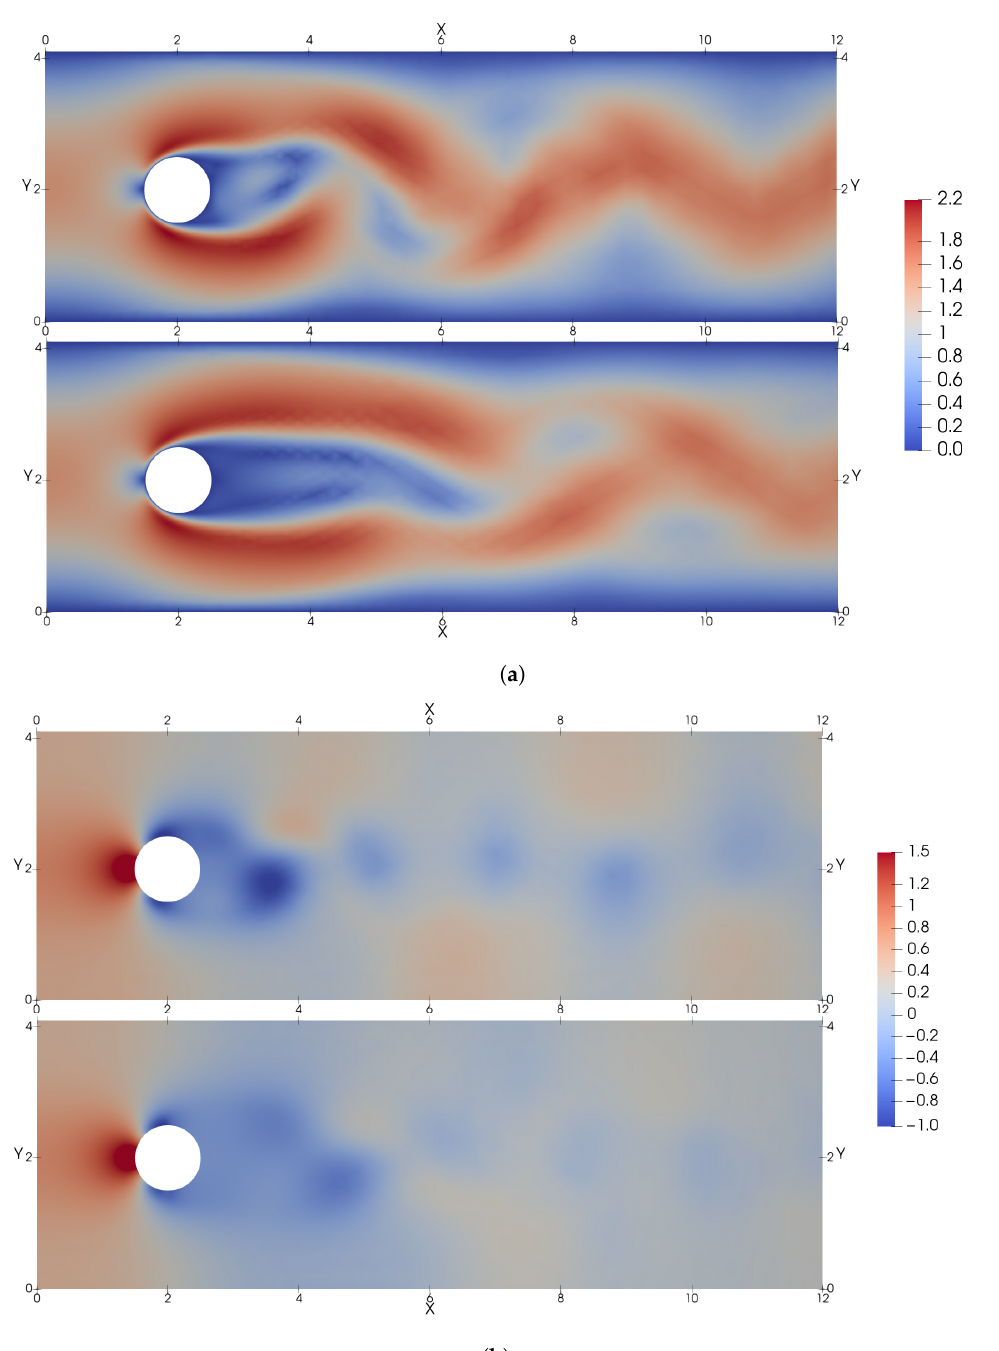
Figure 10. Instantaneous flow fields at Re = 100, where for each pair of images, the baseline case without control is depicted on the top and the controlled case is depicted on the bottom. ( a ) Instantaneous magnitude of the velocity fields. ( b ) Instantaneous pressure